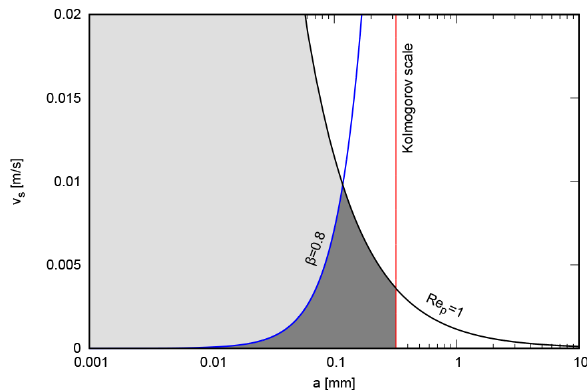
Figure 2. Settling velocities and particle sizes for which Eq. (3) holds. Kolmogorov scale is represented by the red line and Re p = 1 with a black line, which bound the area of validity. Blue curve cor- responds to v s = v s (β,a) for β = 0 . 8, the upper bound to v s for typ- ical microplastic densities. Dark shading denotes the plastic particle sizes and corresponding settling velocities for which application of Eq. (3) is